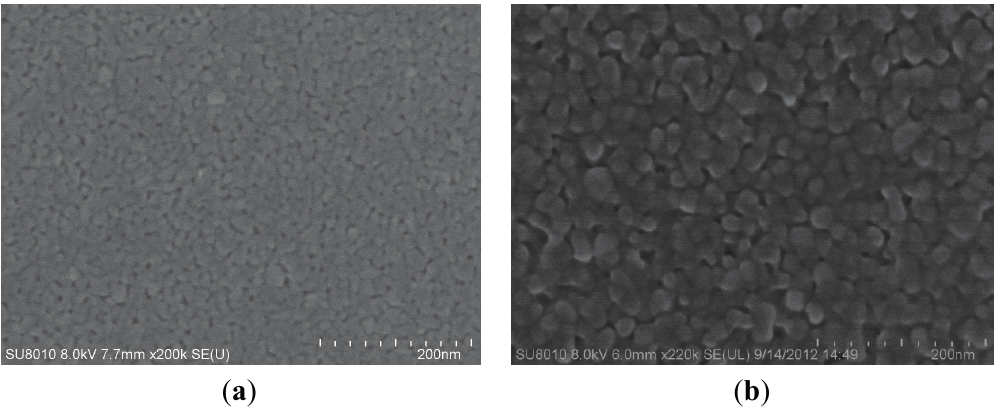
/Pd/TiO thin film at 240 °C with 2 2